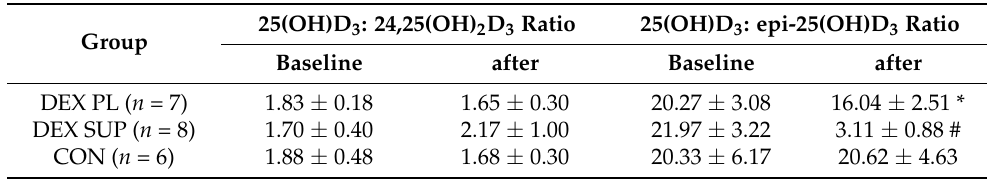
Table 1. The 25(OH)D 3 and its metabolite ratios at baseline and the end of the experiment in DEX-treated rats.